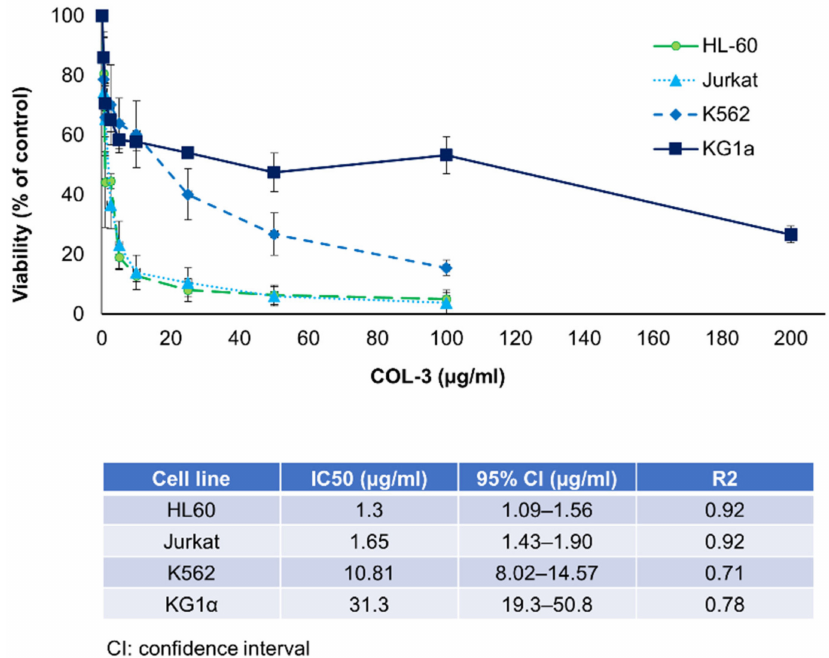
Figure 1. The effect of COL-3 on the viability of human leukemic cell lines. The leukemic cell lines were incubated with COL-3 in concentrations within a range of 0.5–200 µ g/mL. Cells incubated in complete medium served as controls. Cell viability was studied using resazurin fluorescence assay and expressed as a percentage of the control. In all experiments, the DMSO final concentration did not exceed 0.2% and showed no cytotoxic effects. Results are expressed as mean ± SD of three independent